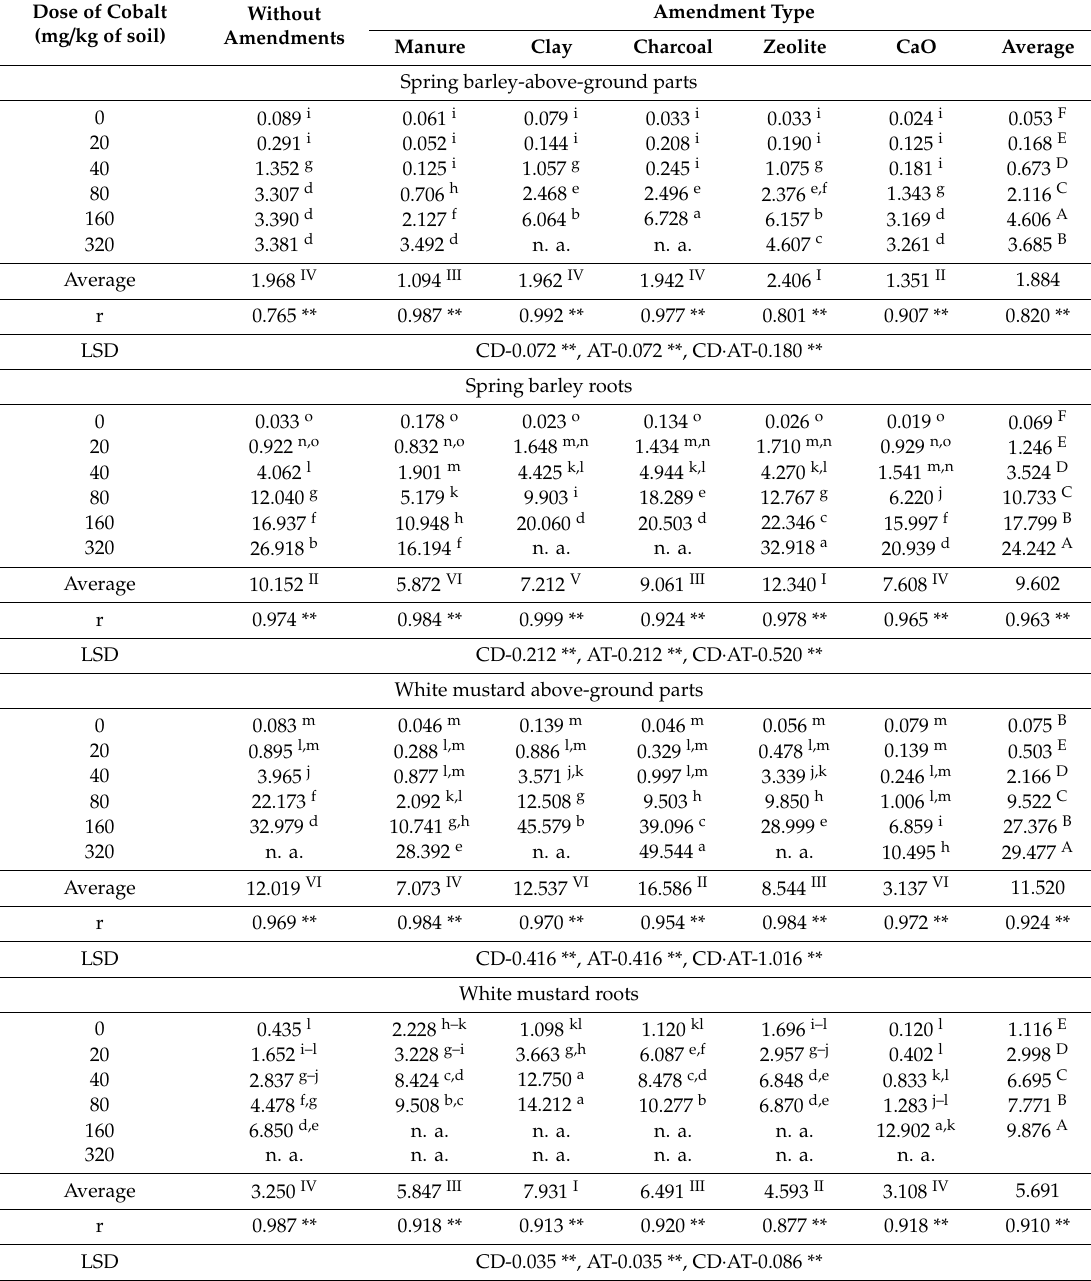
Table 4. Content of cobalt in spring barley and white mustard (mg / kg d.